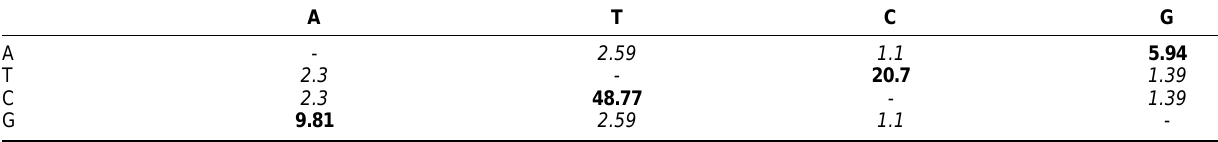
Table-2. Maximum composite likelihood estimate of the pattern of nucleotide substitution using Tamura Nei